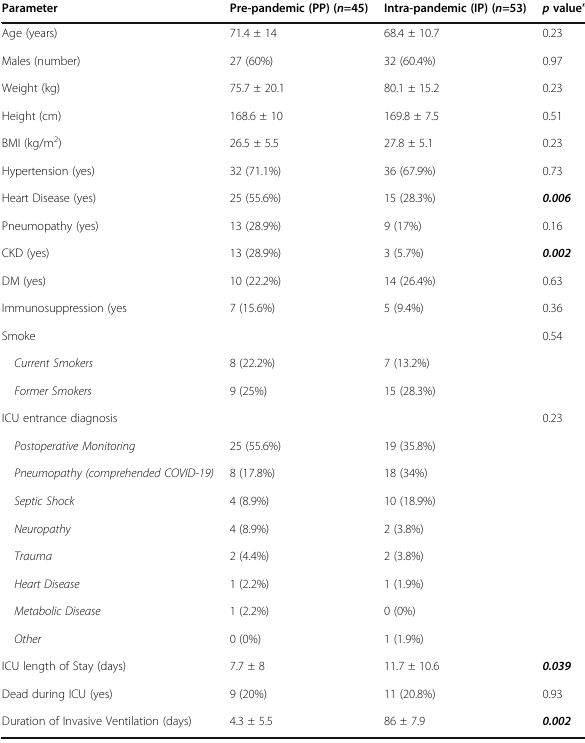
Baseline characteristics, comorbidities, entrance diagnosis and clinical features in thestudy population, divided foryear of admission. Data areexpressed as Mean± SD or number (%),according tothe data BMI Body mass index, CKD chronic kidney disease, DM diabetes mellitus